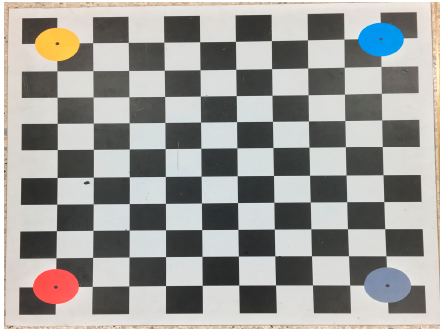
Figure 8. The checkerboard used for camera calibration.